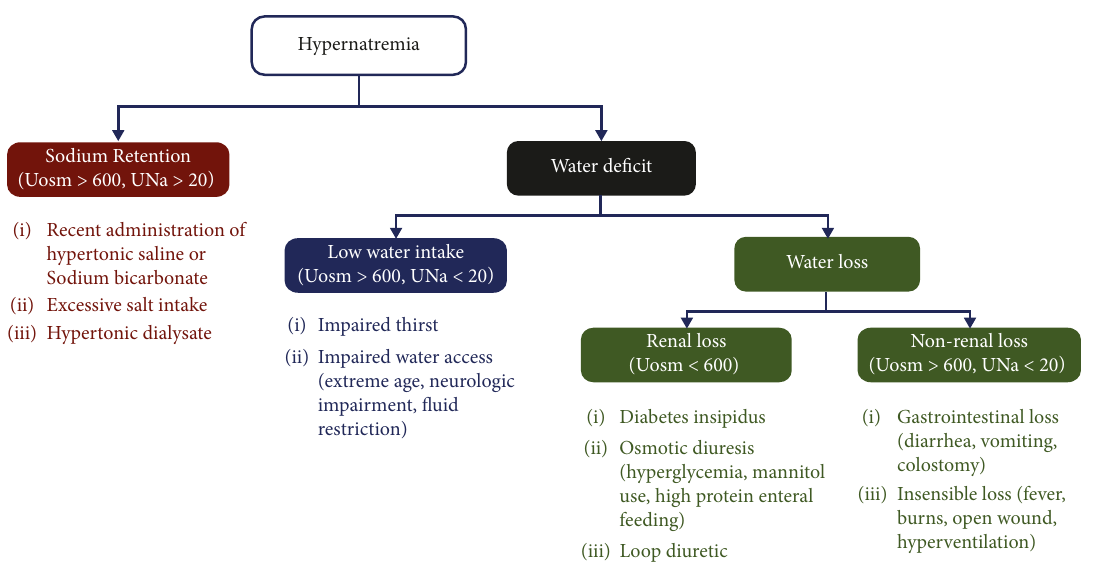
Figure 4: Diagnostic approach to